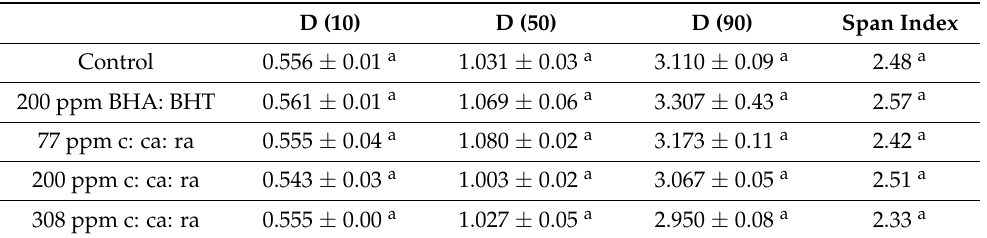
Table 1. Particle size and statistical analysis output for the combined skim milk with sunflower oil (fat fraction) prior to spray drying, with or without the addition of antioxidant agents 1, 2, 3, 4, 5